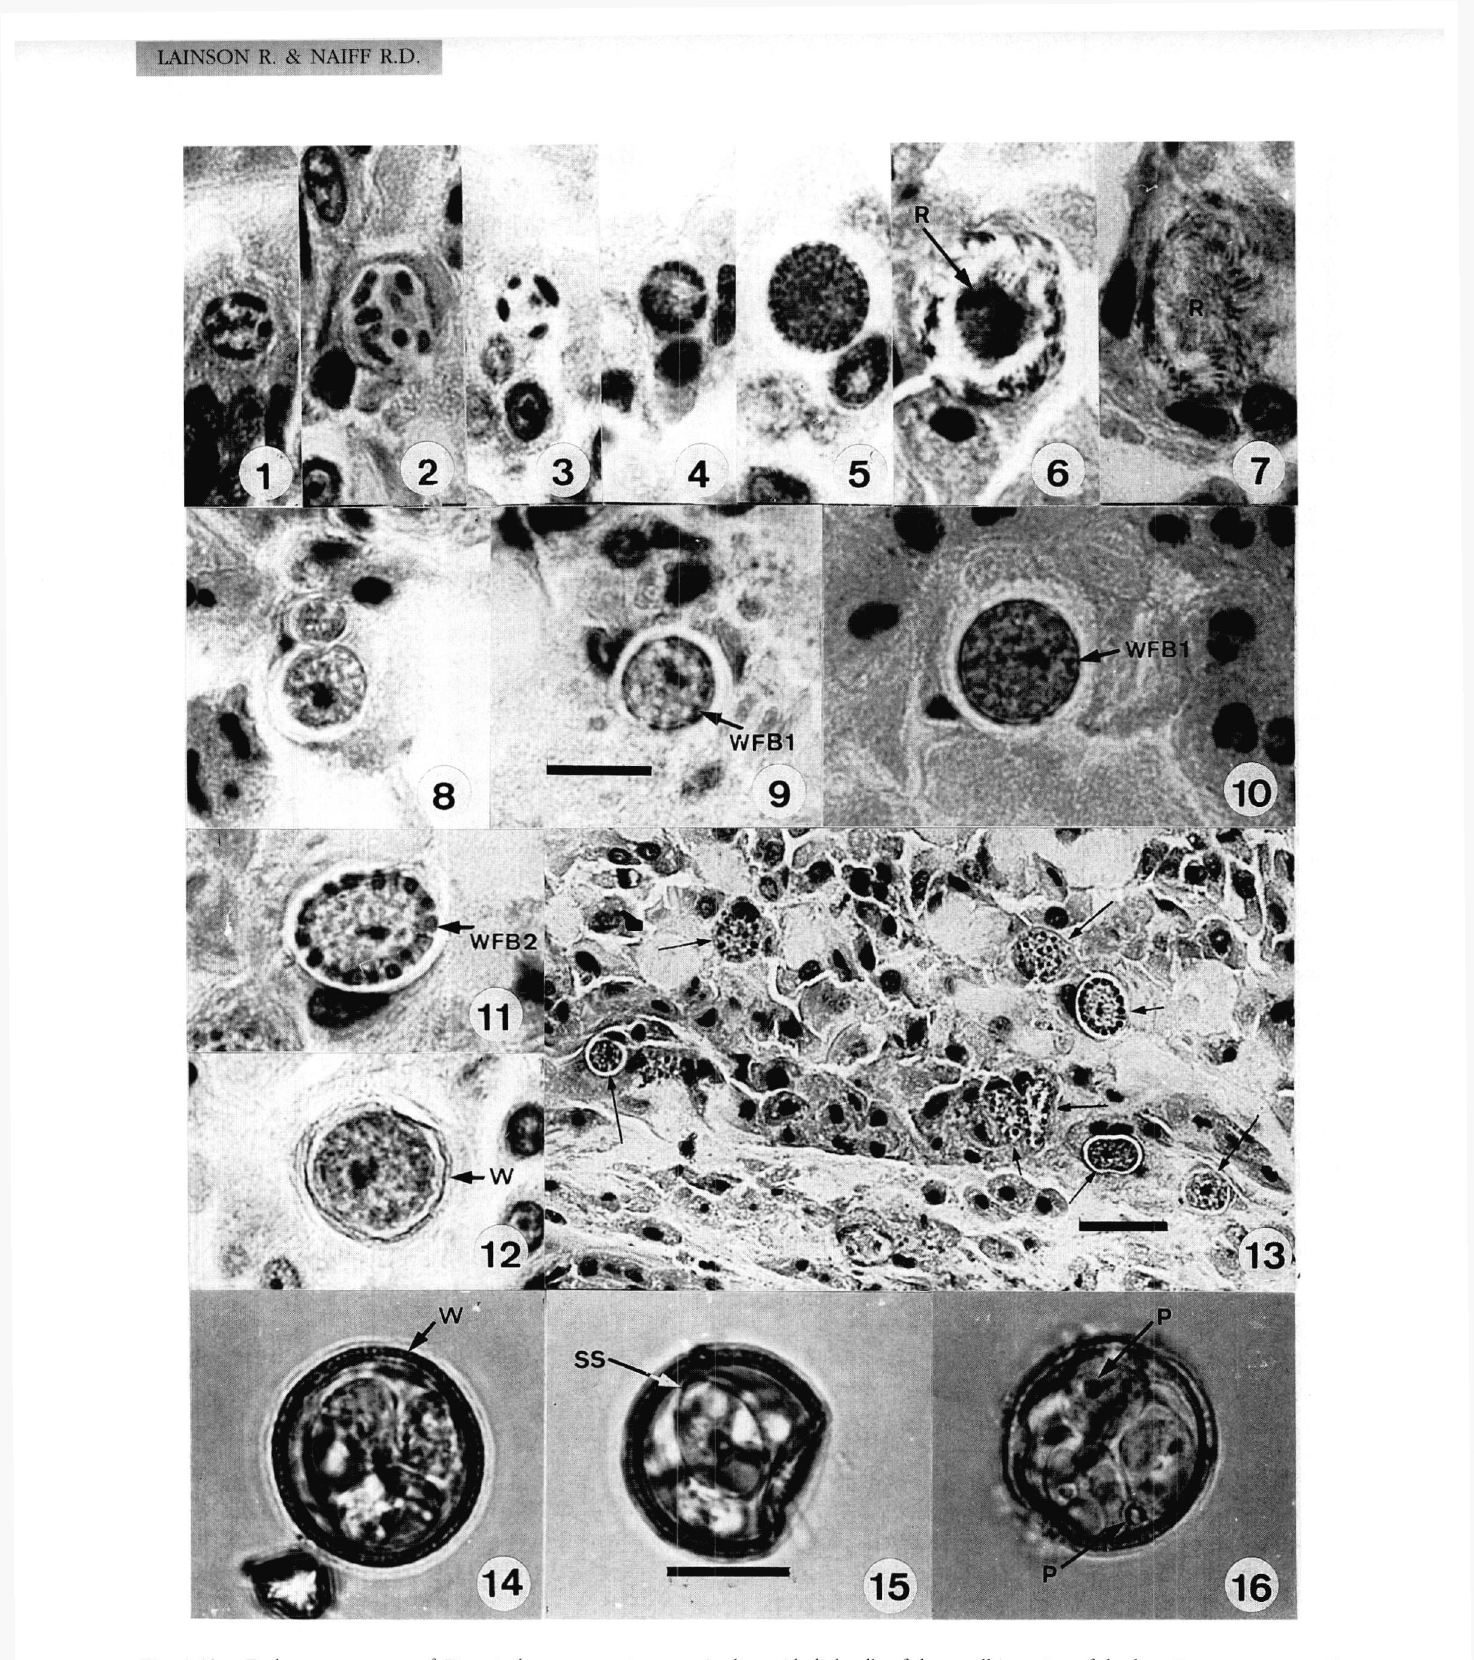
Figs 1-13- - Endogenous stages of Eimeria bragancaensis n. sp., in the epithelial cells of the small intestine of the bat, Peropteryx macrotis. Figs 1, 2. Developing and segmented meronts. Figs 3-5. Growing microgamonts. Figs 6, 7. Mature microgamonts shedding microgametes. Fig. 8. Young macrogamonts. Figs 9,10. Growing macrogamonts: note large numbers of cytoplasmic inclusions, probably amylopectin gra­ nules. Fig. 11. Mature macrogamont. Fig. 12. Young oocyst. Fig. 13. Sloughing of epithelial cells and parasites (arrowed) into the gut lumen. Figs 14-16. - Mature oocysts in the faeces. P = polar bodies; R = microgamont residuum; SS = Stieda and substiedal bodies; W = inner oocyst wall layer; WFB 1 = small type 1 wall- forming bodies; WFB 2 = large type 2 wall-forming bodies. Bars = 10 um. That in Fig. 9 also applies to Figs 1-12. 124 Mémoire